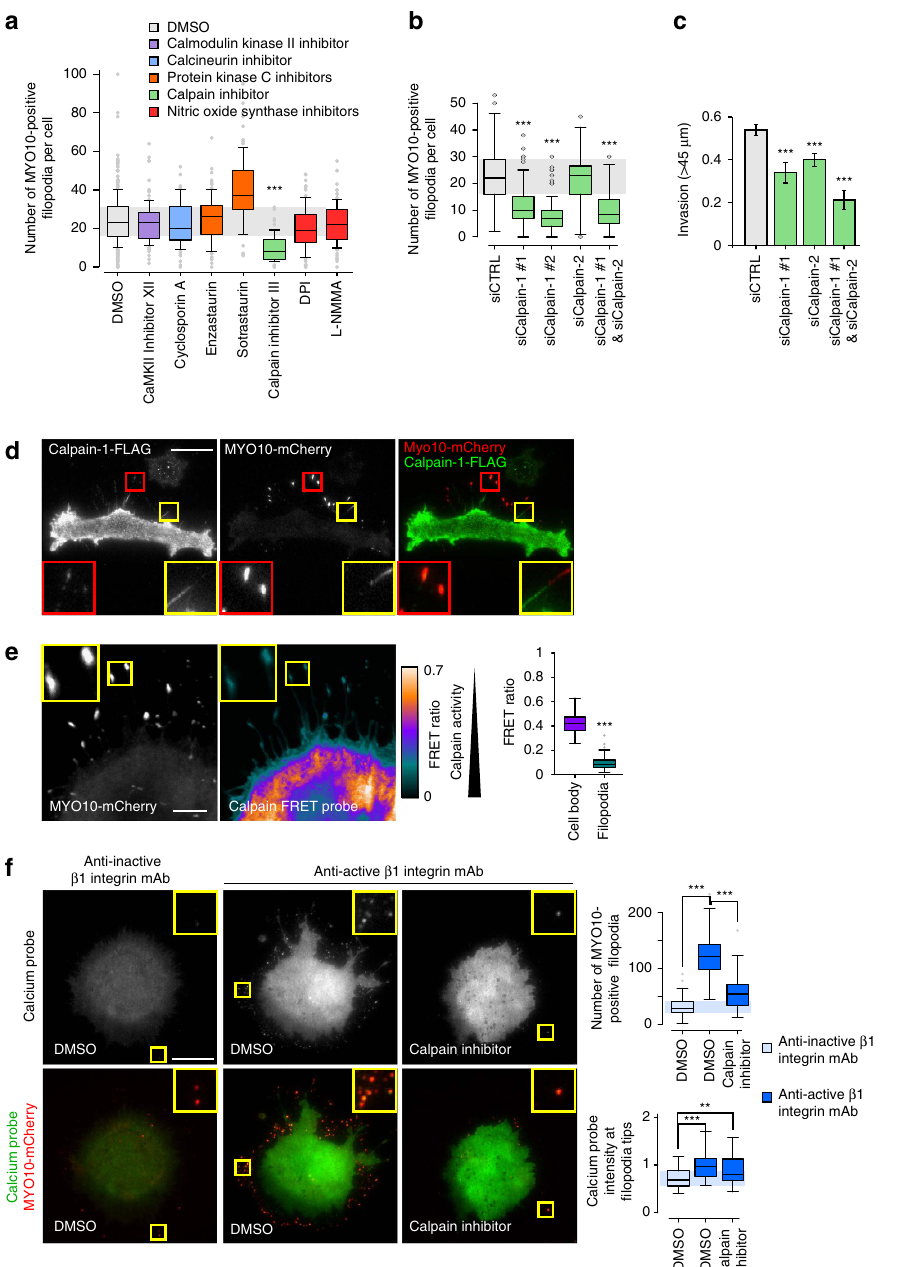
Figure 7 | Calpain-1 regulates filopodia formation. ( a ) MDA-MB-231 cells transiently expressing MYO10-GFP were plated on FN, treated for 1h with various inhibitors (10 m M with the exception of cyclosporin A, enzastaurin and sotrastaurin used at 1 m M) directed against calcium-regulated pathways, fixed and imaged on a TIRF microscope. The number of MYO10-positive filopodia per cell was counted ( n 4 86 cells, three biological repeats; *** P value o 2.4 (cid:3) 10 (cid:2) 24 ). ( b ) MDA-MB-231 cells previously silenced for calpain-1, using two distinct siRNA, and/or for calpain-2, and transiently expressing MYO10-GFP, were plated on FN for 2h, fixed and the number of MYO10-positive filopodia per cell was quantified ( n 4 62 cells, three biological repeats; *** P value o 4.01 (cid:3) 10 (cid:2) 11 ). ( c ) MDA-MB-231 cells previously silenced for calpain-1 and/or for calpain-2 were seeded into an inverted invasion assay and allowed to invade for 48h. Relative invasion over 45 m m was quantified (three biological repeats, *** P value o 1.2 (cid:3) 10 (cid:2) 4 ). ( d ) MDA-MB-231 cells transiently expressing MYO10-mCherry and FLAG-calpain-1 were plated on FN for 2h, stained with an anti-FLAG antibody and imaged on a TIRF microscope (scale bar, 20 m m). ( e ) MDA-MB-231 cells transiently expressing MYO10-mCherry and a calpain FRET probe (pCMV-calpainsensor; CFP and YFP linked by a calpain cleavage site, low FRET ¼ higher calpain activity) were plated on FN and imaged on a confocal microscope (scale bar, 5 m m). The averaged FRET ratios measured in filopodia and in the cell body are displayed (three biological repeats, cell body n ¼ 23, filopodia n ¼ 236; *** P value o 8.9 (cid:3) 10 (cid:2) 15 ). Controls relative to this FRETexperiment are presented in Supplementary Fig. 11. ( f ) MDA-MB-231 cells transiently expressing MYO10-mCherry and the calcium probe were plated on conformation-specific anti- b 1 integrin antibodies (as in Fig. 5g) in the presence of DMSO or a calpain inhibitor (10 m M) (scale bar, 20 m m). The number of MYO10-positive filopodia per cell and the calcium probe intensity at filopodia tips were measured ( n 4 74 cells, three biological repeats; ** P value o 4.3 (cid:3) 10 (cid:2) 3 , *** P value o 3.06 (cid:3) 10 (cid:2) 6 ). P values were calculated using Student’s t -test (unpaired, two-tailed, unequal